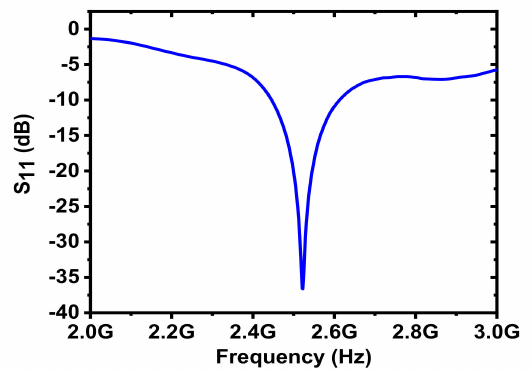
Figure 9. Energy harvesting measurements: ( a ) PTE vs. distance; ( b ) transient output with electrode load (100 ms Tx pulse width).